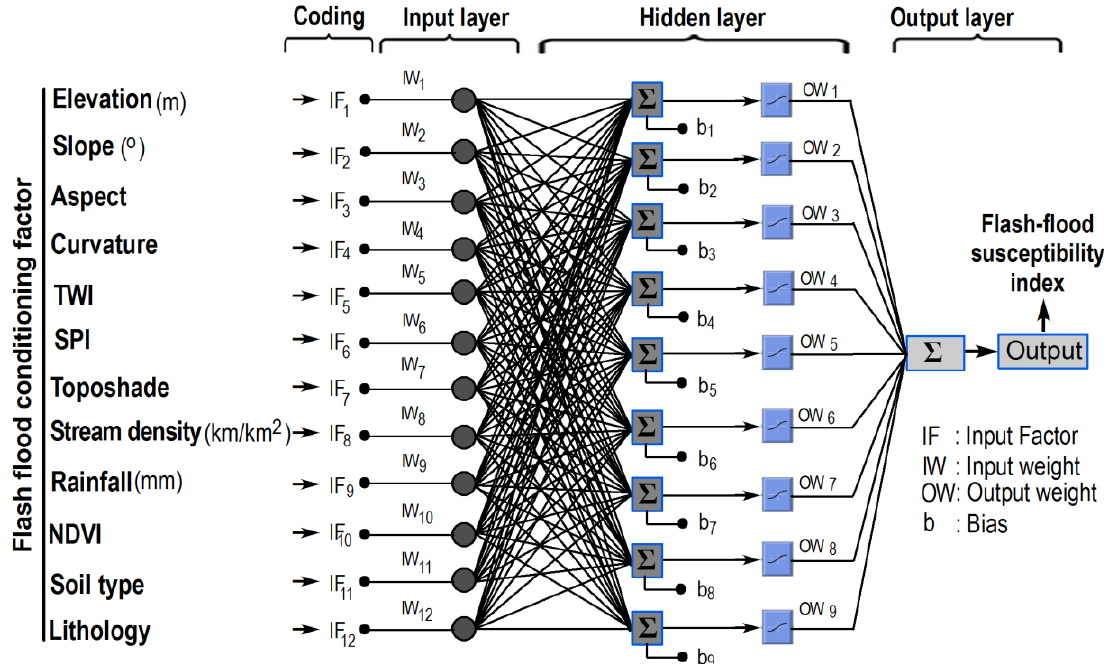
Figure 12. The final trained FA-LM-ANN model for flash-flood susceptibility mapping in this study.